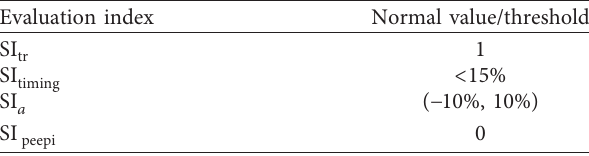
Table 3: The thresholds of the evaluation indices.